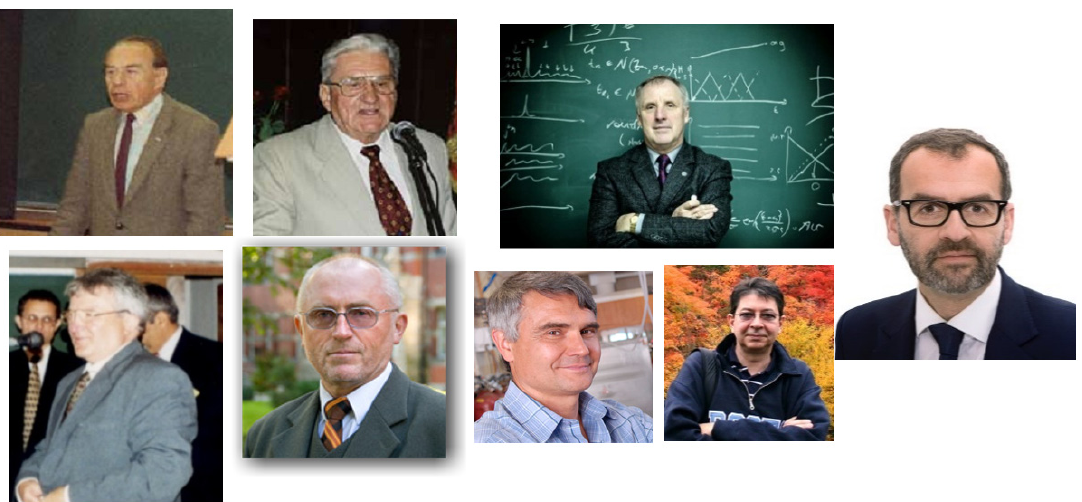
Figure 6. Gda´nsk leaders of separation techniques (top row from the left: J. Kowalczyk, R. Staszewski, Figure 6. Gda ń sk leaders of separation techniques (top row from the left: J. Kowalczyk, R. R. Kaliszan, P. Stepnowski, bottom row: A. Stołyhwo, J. Namie´snik, J. Pawliszyn, T. G ó Staszewski, R. Kaliszan, P. Stepnowski, bottom row: A. Sto ł yhwo, J. Namie ś nik, J. Pawliszyn, T. Górecki).